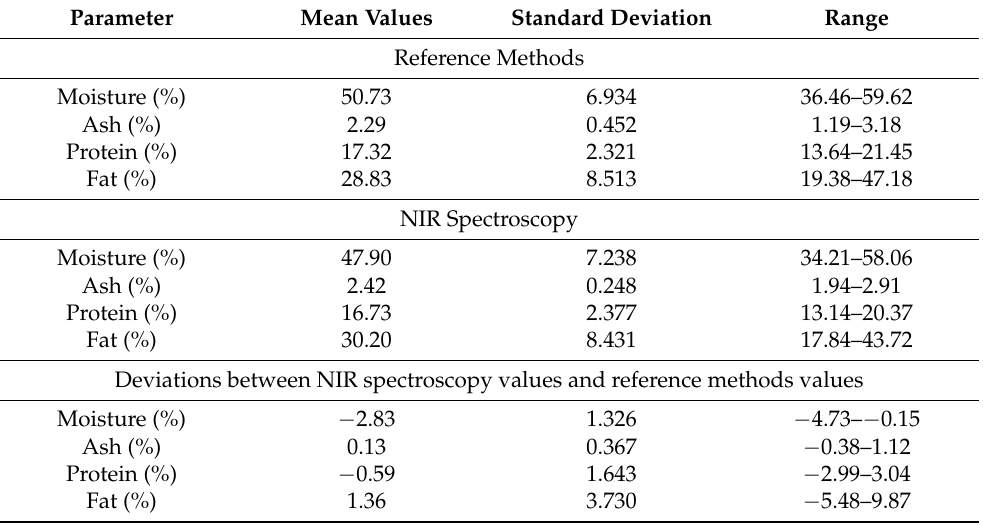
Table 3. Chemical composition according to reference measurements and NIR spectroscopy for external validation samples and deviations between NIR spectroscopy values and reference methods values (n = 10). Parameter Mean Values Standard Deviation